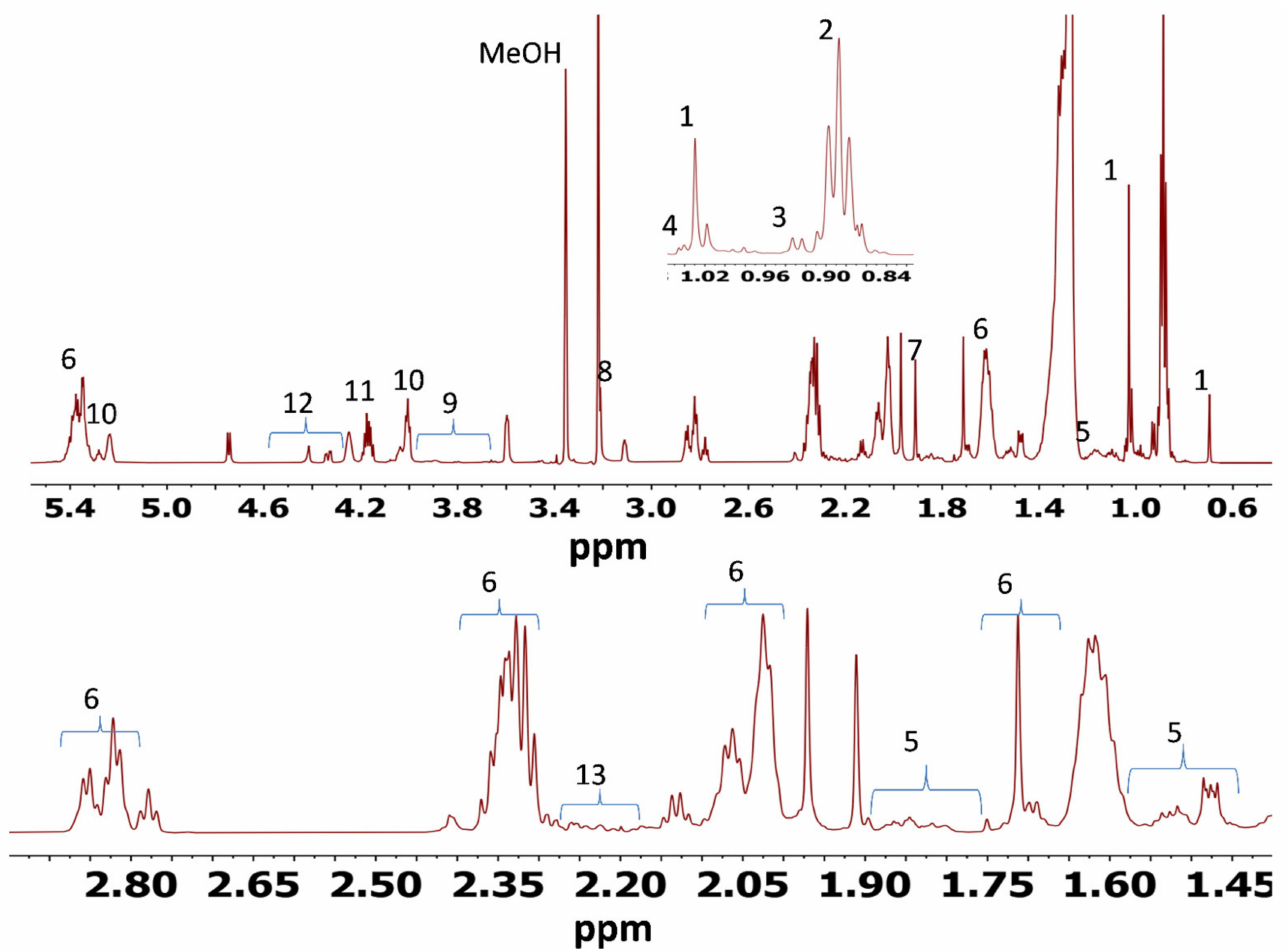
Figure 3. 700 MHz 1 H NMR spectrum of nonpolar extract of Dorper sheep liver tissue: 1. free cholesterol, 2. sphingomyelin, 3. total cholesterol, 4. esterified cholesterol, 5. multiple cholesterol protons, 6. fatty acyl chain, 7. acetate, 8. choline, 9. glycerophosphocholine, 10. glycerophospholipid backbone, 11. glycerol backbone, 12. phosphatidyl choline and 13.